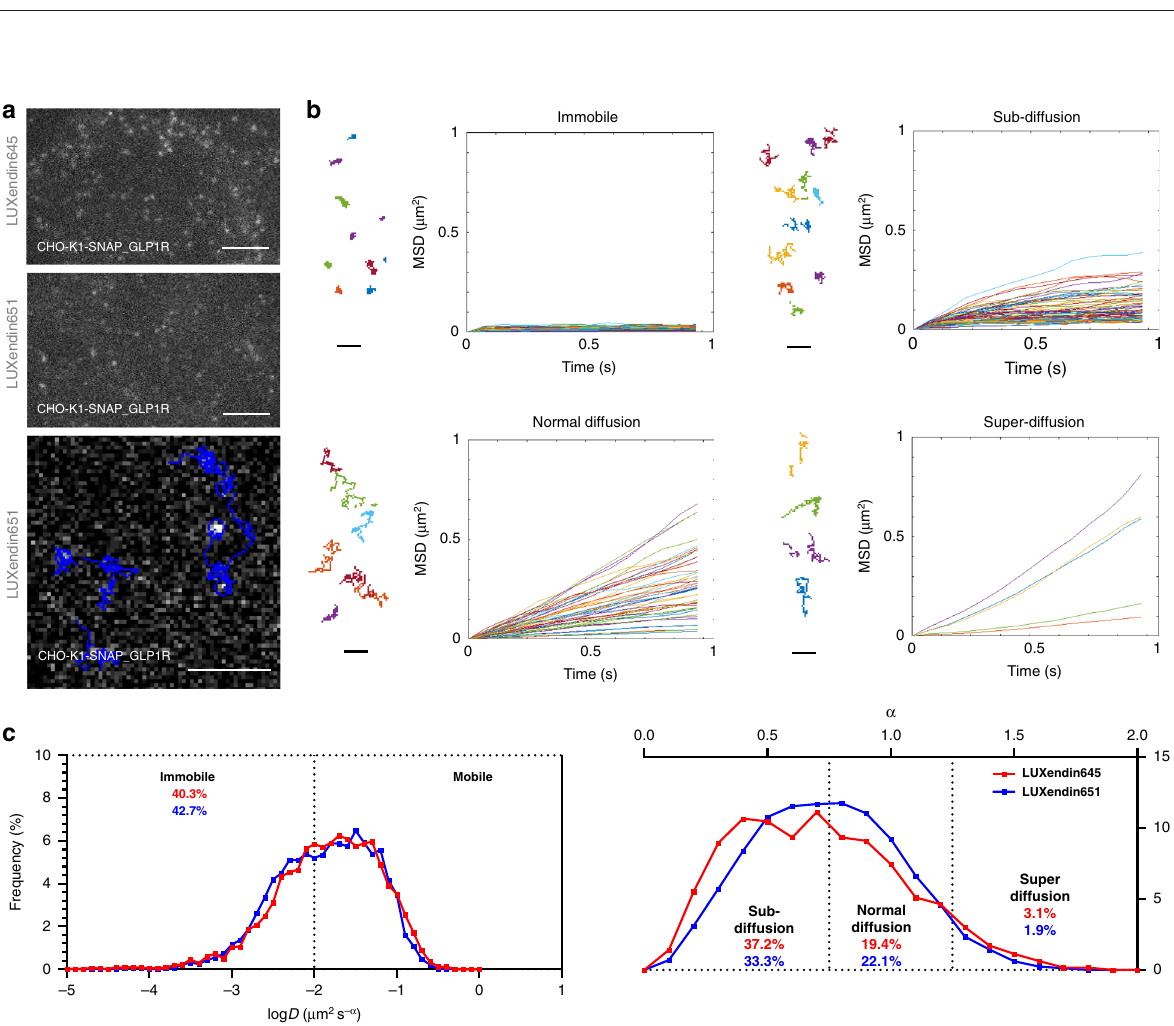
Fig. 5 LUXendin651 and LUXendin645 allow nanoscopic detection of GLP1R. a LUXendin645 allows super-resolution snapshots of MIN6 β -cells using wide fi eld microscopy combined with super-resolution radial fl uctuations (SRRF) (representative image from n = 8 images, three independent repeatss) (scale bar = 10 µ m for full- fi eld images, 2.5 µ m for zoomed-in images). b – d Confocal and STED snapshots of endogenous GLP1R in LUXendin651 -treated MIN6 cells at FWHM = 70 ± 10 nm (mean ± s.d.; n = 15 line pro fi les measured on the raw data, two independent repeats). Note the presence of punctate GLP1R expression as well as aggregation/clustering in cells imaged just away from b , close to c or next to d the coverslip using STED microscopy (representative image from n = 8 images, three independent repeats) (scale bar = 2 µ m for full- fi eld images, 1 µ m for zoomed-in images). e, f Representative graph showing spatial analysis of GLP1R expression patterns using the F-function e and G-function f , which show distribution (red line) vs. a random model (black line; 95% con fi dence interval shown) ( n = 6 from three independent repeats). g Approximately 1 in 4 MIN6 β -cells possess highly concentrated GLP1R clusters. h, i LUXendin651 allows GLP1R to be imaged in living MIN6 cells using SRRF h and STED i (representative image from n = 6 and 18 images, three independent repeats for SRRF and STED, respectively) (scale bar = 10 µ m for full- fi eld SRRF image, 2.5 µ m for the zoomed-in image) (scale bar = 2 µ m for STED images). White boxes show the location of zoom-ins. The following compound concentrations were used: 100 nM LUXendin645 (SRRF) and 100 – 400nM LUXendin651 (STED). Mean± s.e.m. are shown. Source data are provided as a Source Data fi le.